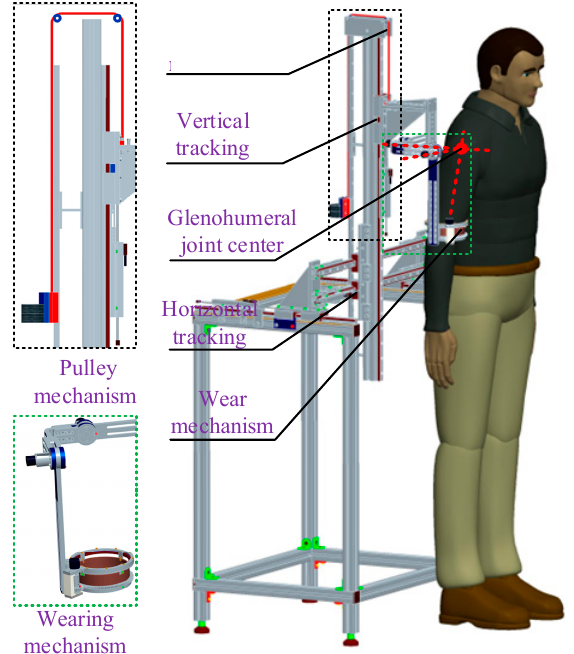
Figure 3. Wearable detection mechanism.